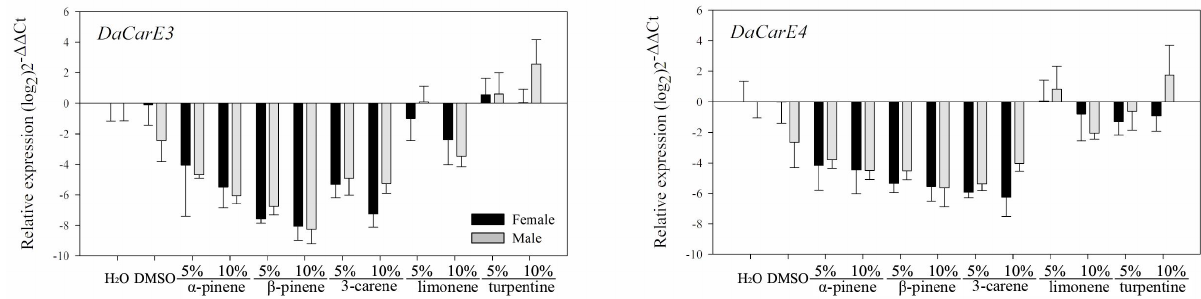
Figure 7. Realtime qPCR analysis of the relative expression of two CarE genes (mean ± SE) in D. armandi after fed on a purely artificial diet with stimuli at different concentrations for 24 h. Values > 1 on the logarithmic y-axis indicate upregulation. Gene expression was normalized with respect to the geometrical mean of β -actin and CYP4G55. Statistically significant differences in gene expression among concentrations are shown in Table 3. The 2 − ∆∆ Ct and SE values were log 2 transformed for